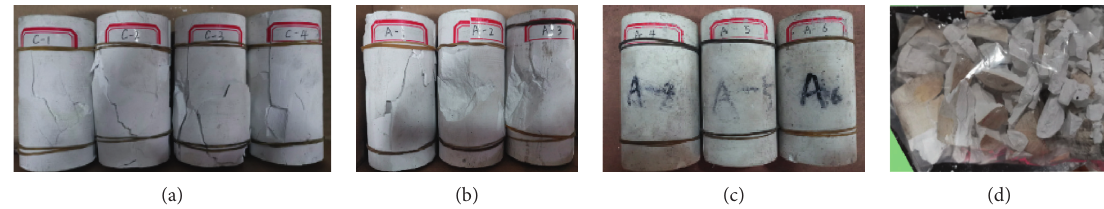
Figure 12: Failure modes of uniaxial compression of each group of samples. (a) Natural. (b) Dehydration at 45 ° C. (c) Water saturation. (d) High-temperature dehydration at 220 ° C.